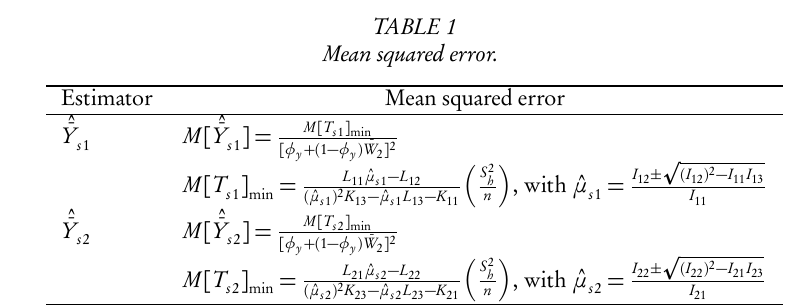
Mean squared error.